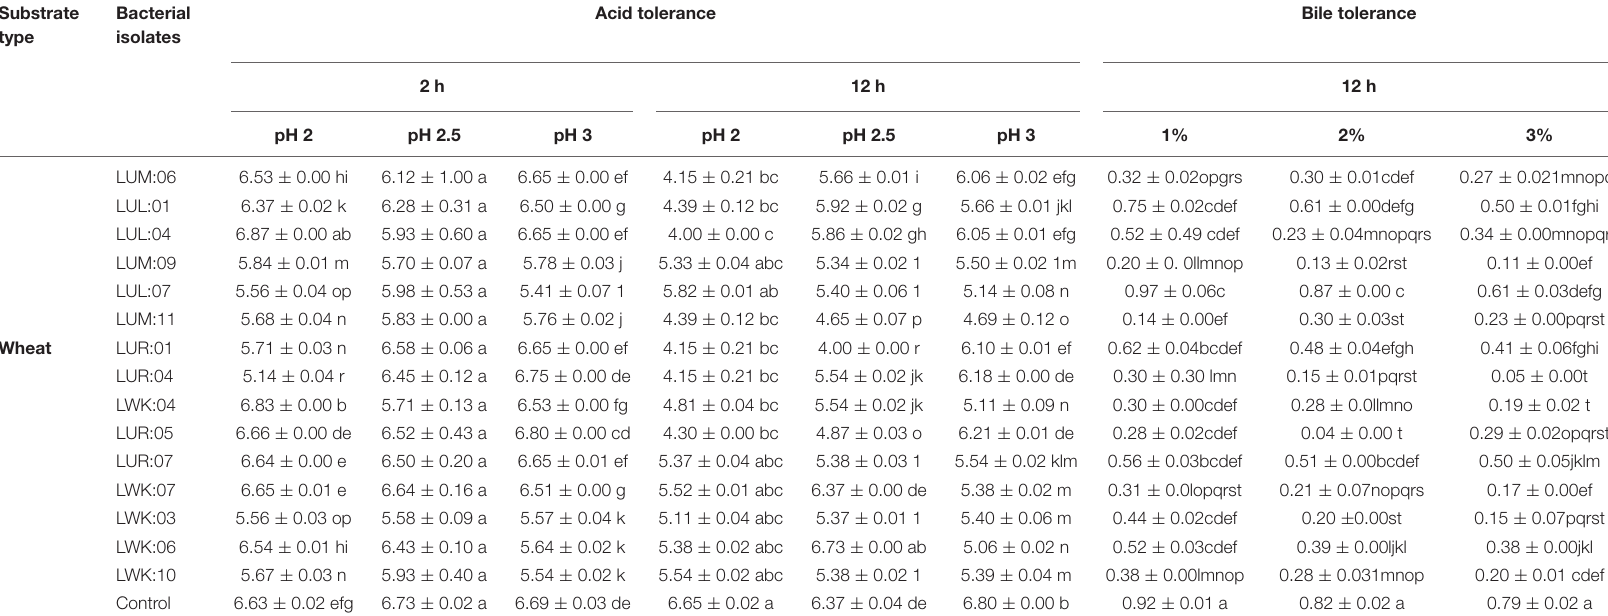
Values represented as mean ± SD; for each row, different subscripts upper case letters indicate significantly different at p < 0.05, as measured by 2-sided Tukey’s HSD between pH 2, pH 2.5, and pH 3 Control and bile salt% 1, 2, and 3. Acid tolerance (Values expressed in log10CFU/ml in 2 and 12 h) whereas; For bile tolerance (Values represented in OD at the absorbance A560nm). Lacticaseibacillus rhamnosus (ATCC 53103) are reference